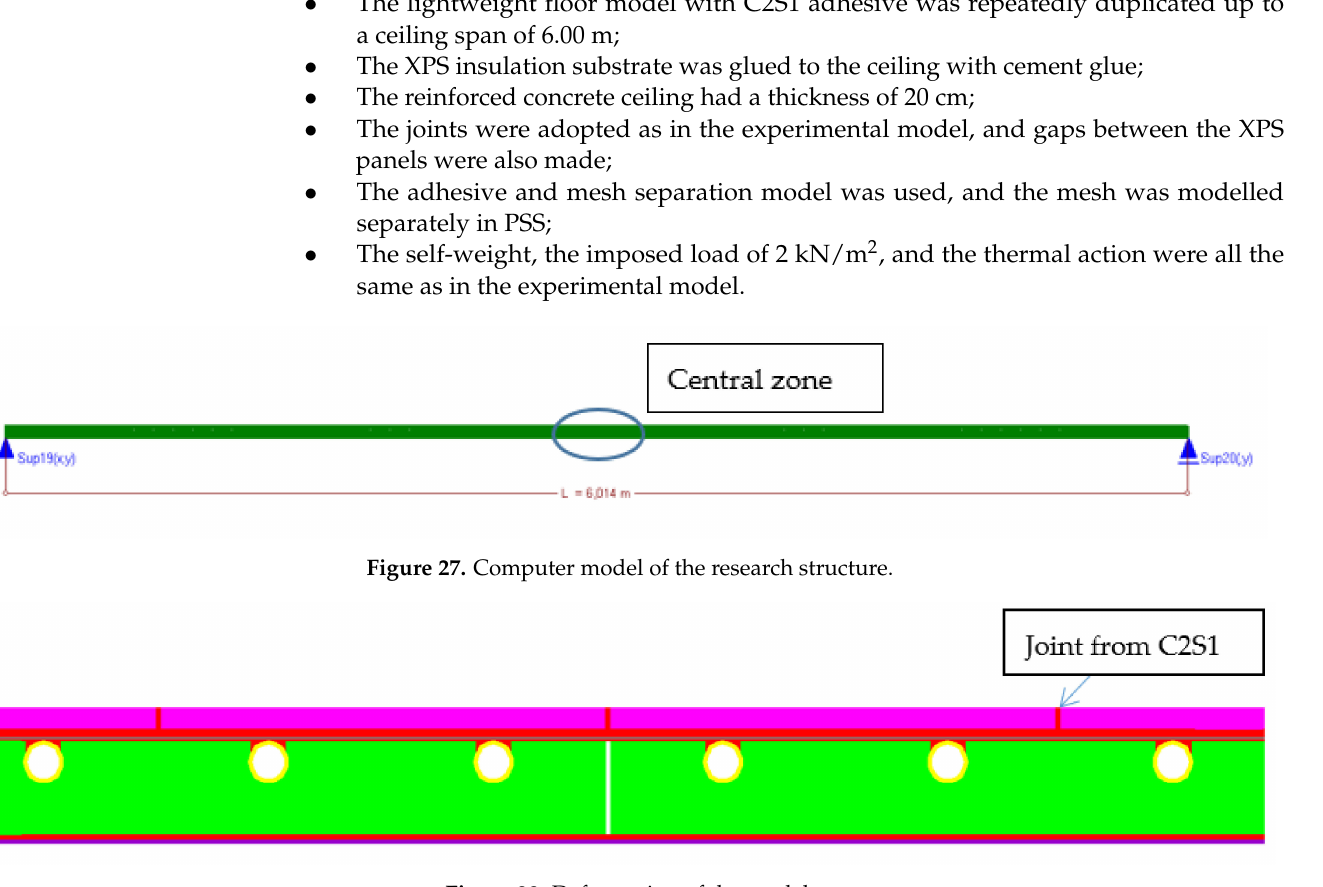
Figure 28. Deformation of the model.